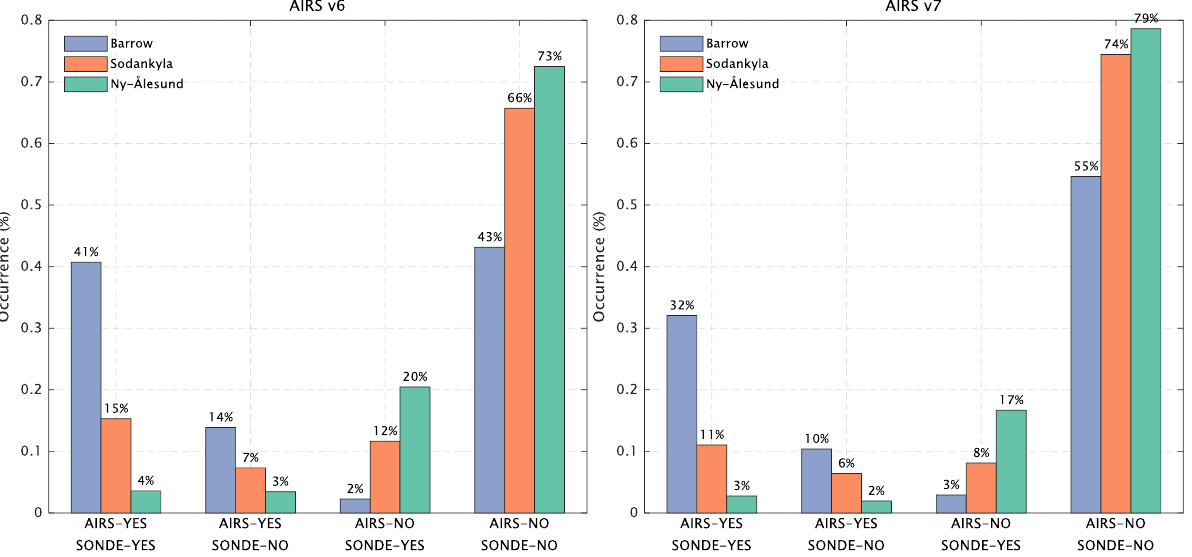
Figure 7. LLI detection agreement between the AIRS and the kerned sonde products. The label “AIRS-YES and SONDE-YES” indicates the matched profiles where both the AIRS and the sonde detected an LLI. The label “AIRS-NO and SONDE-YES” indicates the matched profiles where the AIRS did not detect an LLI, but the sonde did. The blue, orange, and green bars each represent the results of the three stations.